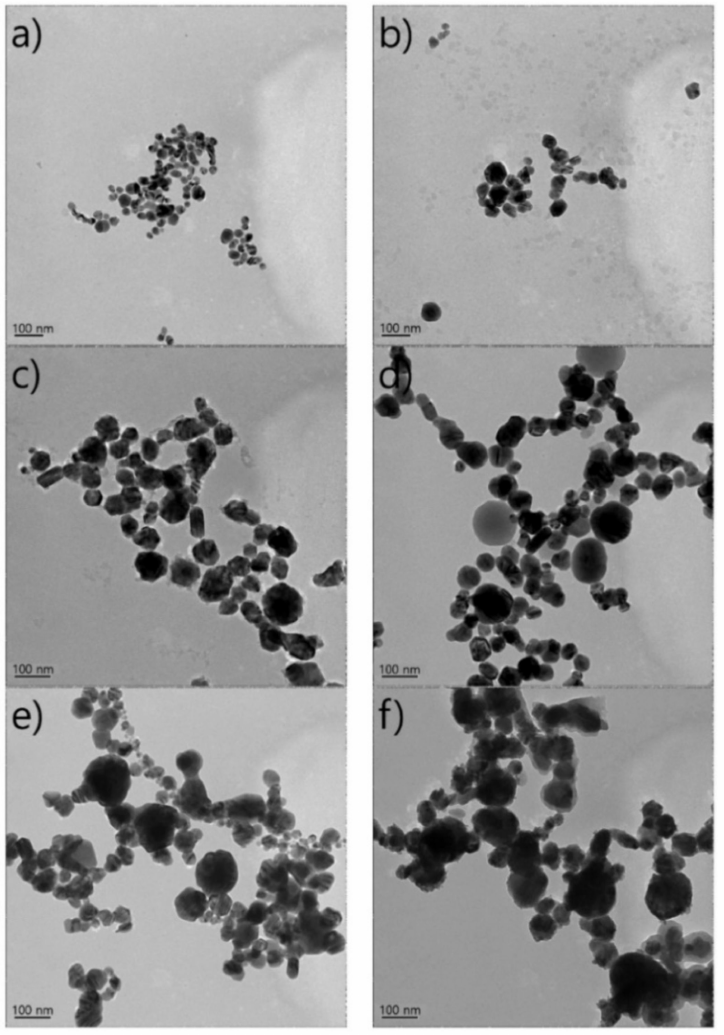
Figure 7. Transmission electron microscopy images showing variations in shapes of dried Ag nanoparticles using different pulse durations: ( a ) 164 fs, ( b ) 5 ps, ( c ) 4 ns, ( d ) 32 ns, ( e ) 64 ns, and ( f ) 100 ns. Adapted with permission from Ref. [112]. Copyright 2017, Printed